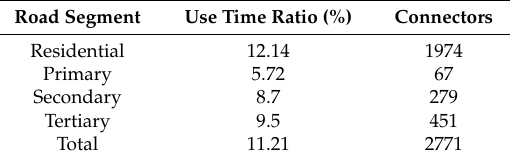
Table 2. Use time ratio by road segment.